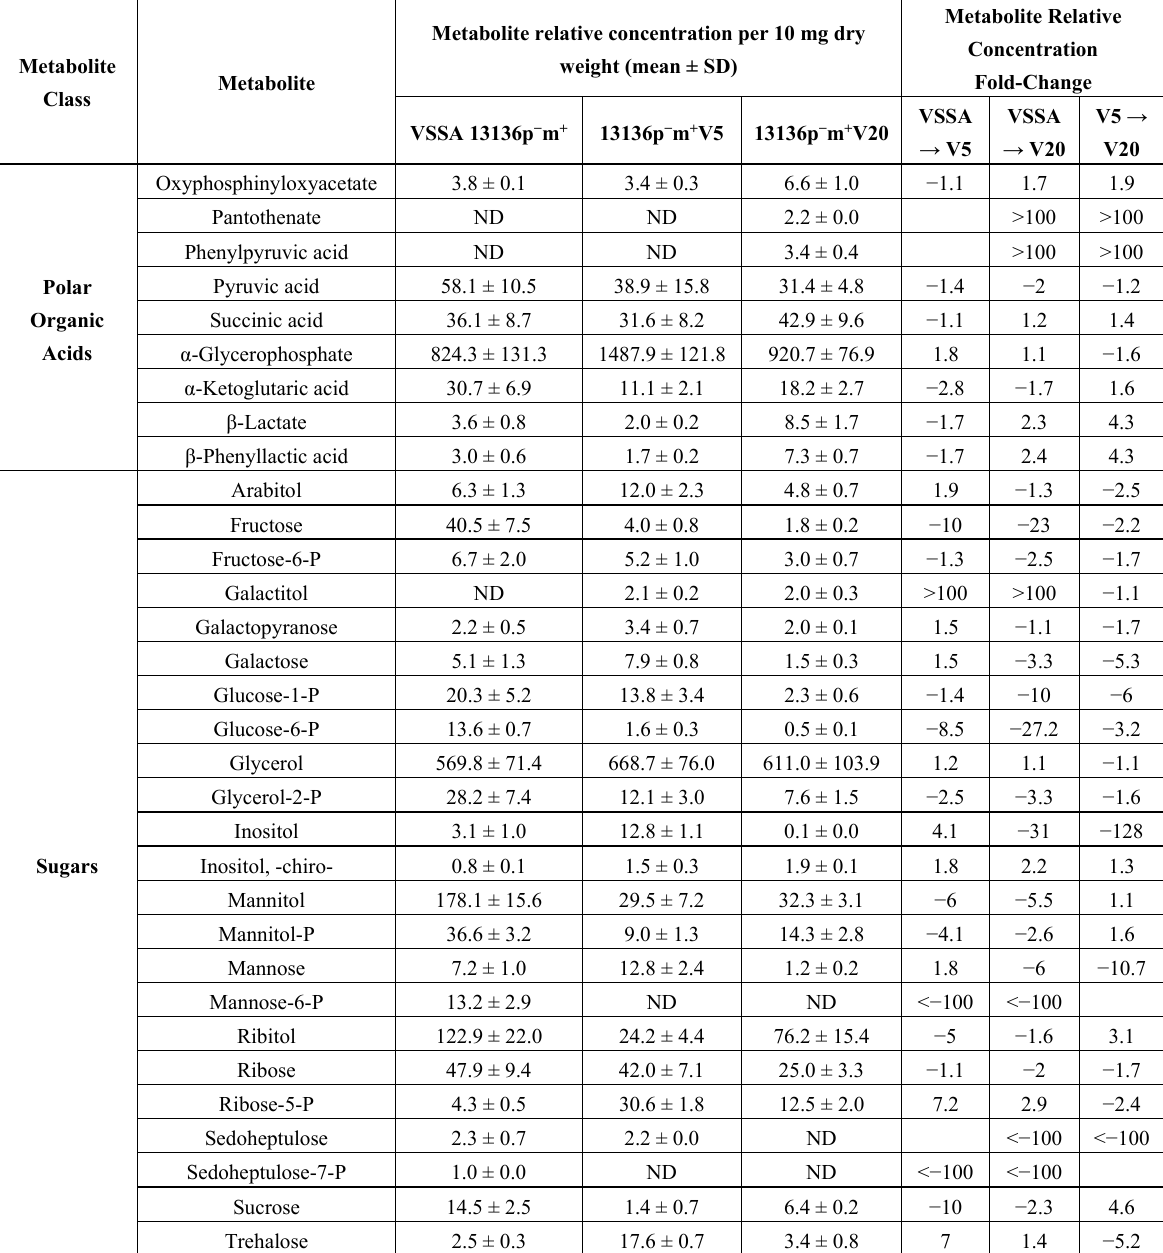
Figure 2 is a set of diagrams of central intermediary metabolic pathways with detected metabolites indicated along with increases and decreases in concentration for all three comparisons of relative concentrations (each VISA versus the parent VSSA and VISA 13136p − m + V20 vs. VSSA 3136p − m + V5). For clarity, only metabolite relative concentration changes of five-fold or greater are presented. Forty five of the 98 metabolites identified had at least one relative concentration change of five-fold or greater among the three strain comparisons. By metabolite class, these were: 13 amines and polyamines, eight amino acids, nine polar organic acids and 15 sugars. These 45 metabolites, their relative concentrations per strain, and relative concentration fold-changes for all three strain comparisons are listed